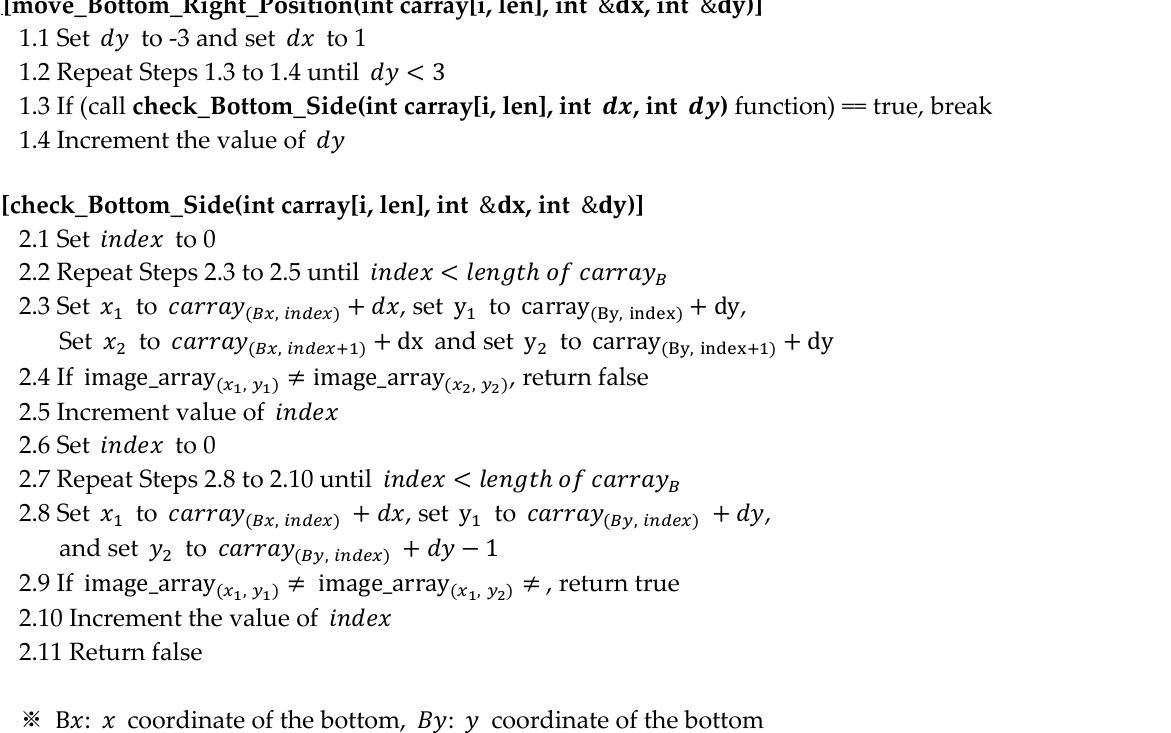
Figure 16. Proposed algorithm for movement to the right and bottom. The pseudocode for updating the circular coordinate array is shown in Figure 17. With the difference coordinate (𝑑𝑥, 𝑑𝑦) and the coordinate array carray[i, len] as the in- puts, it is updated as indicated in Lines 3 and 4.